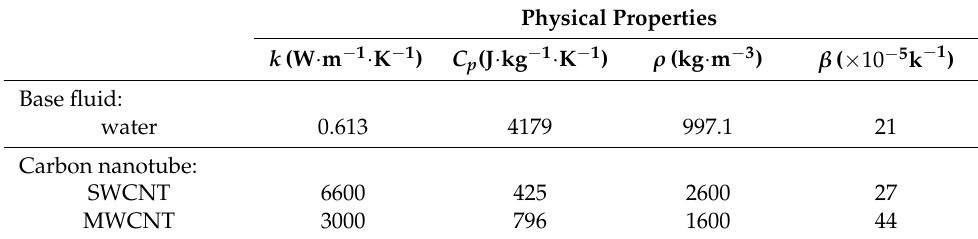
Table 2. Properties of base fluid and carbon